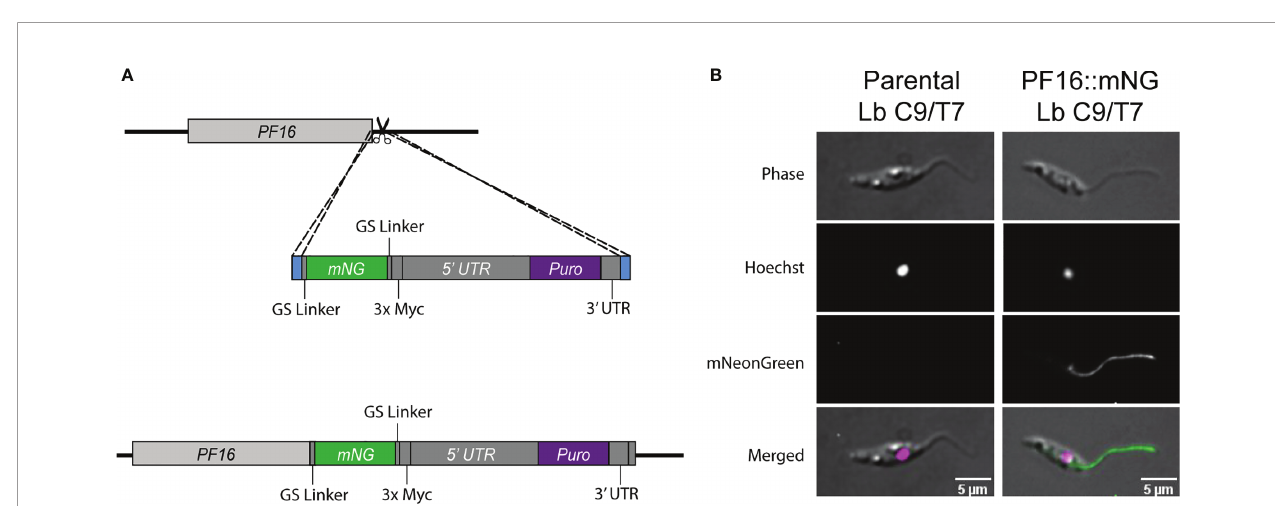
FIGURE 5 | Schematic representation of the strategy used for tagging endogenous PF16 in Lb C9/T7 and localization of PF16 in the transfectants. (A) One sgRNA (scissors) was used to direct Cas9 for a DSB at PF16 3 ′ UTR. A donor DNA containing a mNG CDS (green) and a puromycin resistance marker (purple) and 30 nt long homology arms at each end (blue) were also delivered to mediate DSB repair. (B) Localization of fused PF16::mNeonGreen (PF16::mNG) in Leishmania braziliensis C9/T7. The left column shows images acquired from the parental line (Lb C9/T7), and the right column shows images acquired from the tagged line (Lb C9/T7 PF16::mNG). Each row shows phase contrast, Hoechst (DNA), mNG (tagged CDS), and merged channels, respectively.